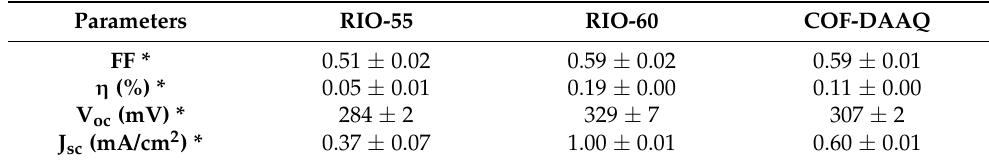
Table 3. Photovoltaic performance parameters of DSSCs based on COFs and RIO as dye replacements using an optimized deposition step under simulated AM 1.5 G illumination at 100 mW/cm 2 . ( The presented results correspond to the best-performing cell ).